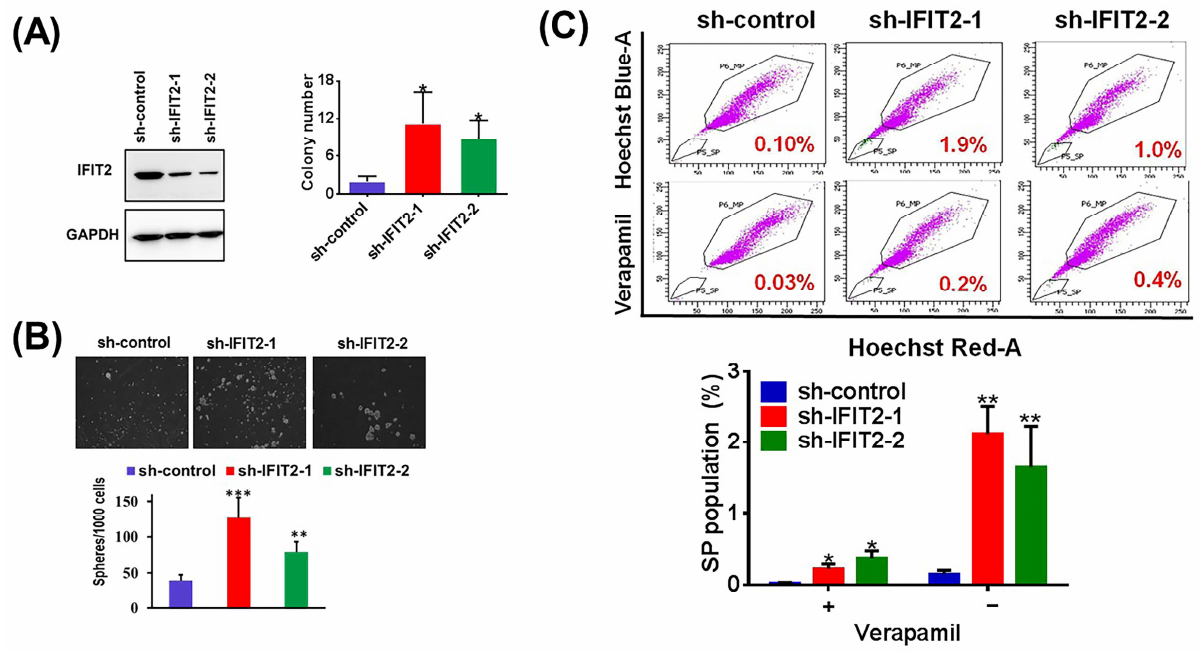
Figure 1. In vitro soft agar colony and spheroid formation in stable IFIT2-depleted cells. ( A ) The IFIT2 protein levels in sh-control and stable IFIT2 knockdown cells were determined by Western blotting. GAPDH expression was used as a loading control (left panel). The results of the anchorage- independent colony formation assay were shown in right panel; ( B ) Representative image of spheroid formation and quantitated data of spheroid numbers counted in three independent experiments in sh-control and stable IFIT2 knockdown cells; ( C ) Representative flow cytometry of SP assay with or without verapamil treatment (upper). The quantitative analysis of the SP population was average of three independent experiments (bottom). The symbols *, ** and *** indicate statistically significant differences compared to sh-control at p < 0.05, p < 0.01 and p < 0.001,